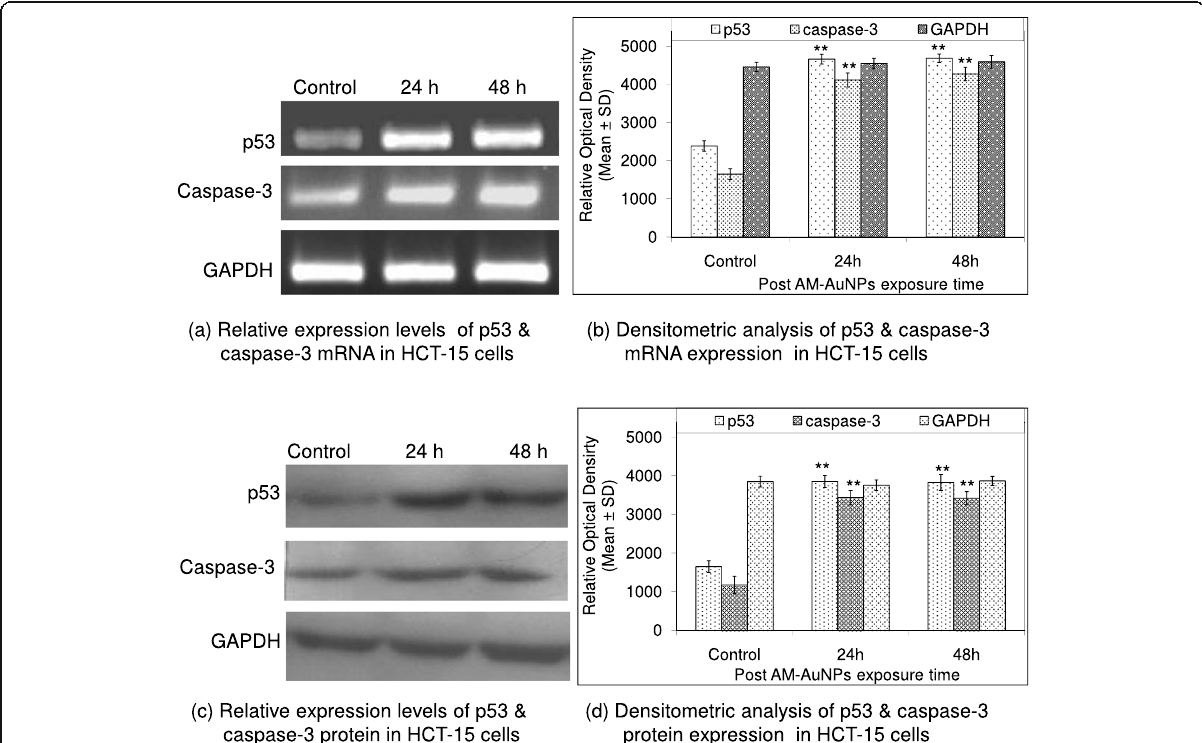
Fig. 7 a Representative semi-quantitative RT-PCR demonstrates the gene expression changes for p53, caspase-3, and GAPDH from HCT-15 cells exposed to IC 50 concentration of AM-AuNPs with different time points of exposure 24 and 48 h. Lane 1 is control; lanes 2 and 3 are mRNA levels of AM-AuNPs exposed cell samples after 24 h and 48 h of exposure. b Histogram showing densitometry analysis of intrinsic apoptosis-related gene expressions of HCT-15 cells after exposure to AM-AuNPs for 24 and 48 h. Error bars indicate standard deviation of mean for three independent experiments. GAPDH expression was used as loading control. c Representative immunoblot showing expression of apoptosis responsive p53 and caspase-3 proteins and GAPDH as internal loading control from HCT-15 cells exposed to IC 50 concentration of AM-AuNPs for 24 and 48 h. d Histogram showing densitometry quantification of apoptotic protein expression. Significant differences assessed by Student ’ s t test are indicated in ** p < 0.001, found to be increased significantly in samples obtained from 24 h and 48 h post exposure periods as compared to unexposed control. Error bars indicate standard deviation of mean for three independent